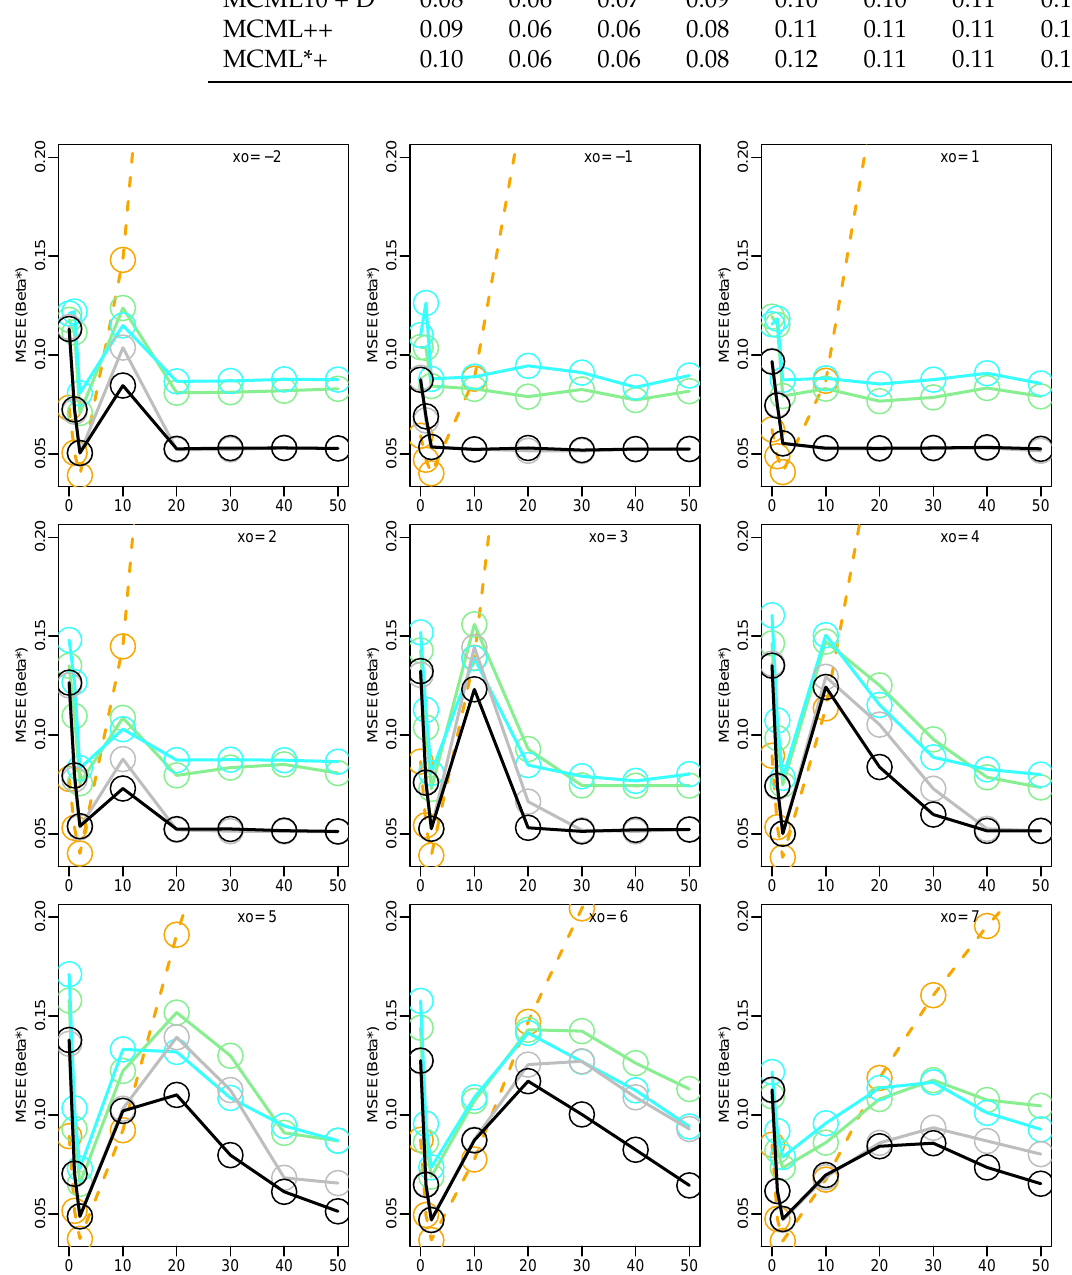
Figure 4. Monte Carlo results for the contaminated multiple regression model. Mean square estimation error MSEE( ˆ β ∗ ) for varying y out and x out . Starting estimates: MD07r, light green; MD10r, cyan; MCML07, grey; MCML10, black; (ML,